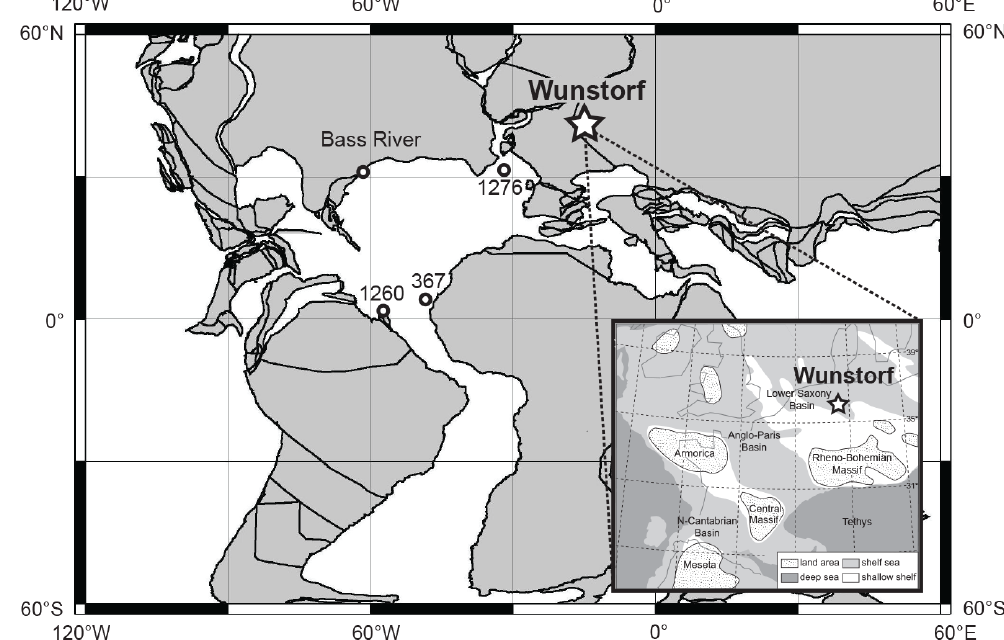
Figure 1. Paleotectonic reconstruction for the Cenomanian–Turonian boundary time interval, with the location of the Wunstorf core and sections with previously published TEX 86 -based SST records: Bass River, DSDP site 367 and ODP sites 1260 and 1276 indicated (map generated at http://www.odsn.de/odsn/services/paleomap/paleomap.html). Inset map shows a detailed paleogeographic reconstruction of central and western Europe, including the location of the Wunstorf core (modified from Voigt et al., 2004).